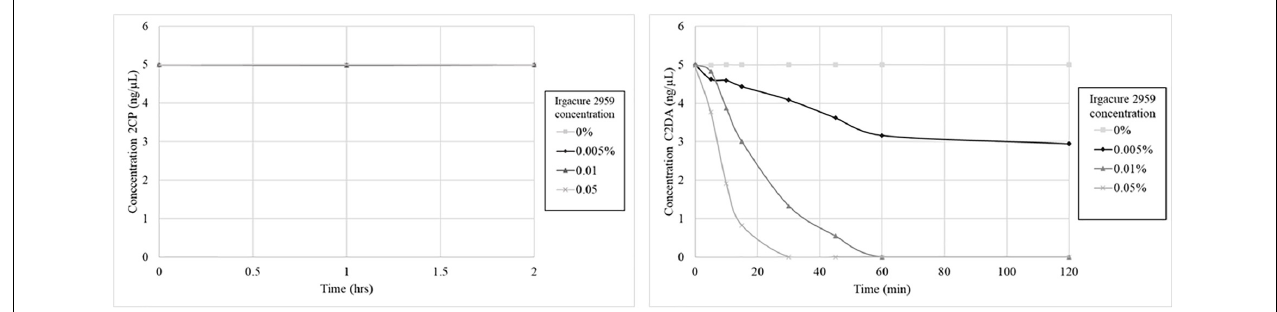
FIGURE 3 | Graphs show 2CP (left) and C2DA (right) short term solution stability over time (4 h total, 2 h shown) and concentration dependence of DSF stability when challenged with UV and the photoinitiator